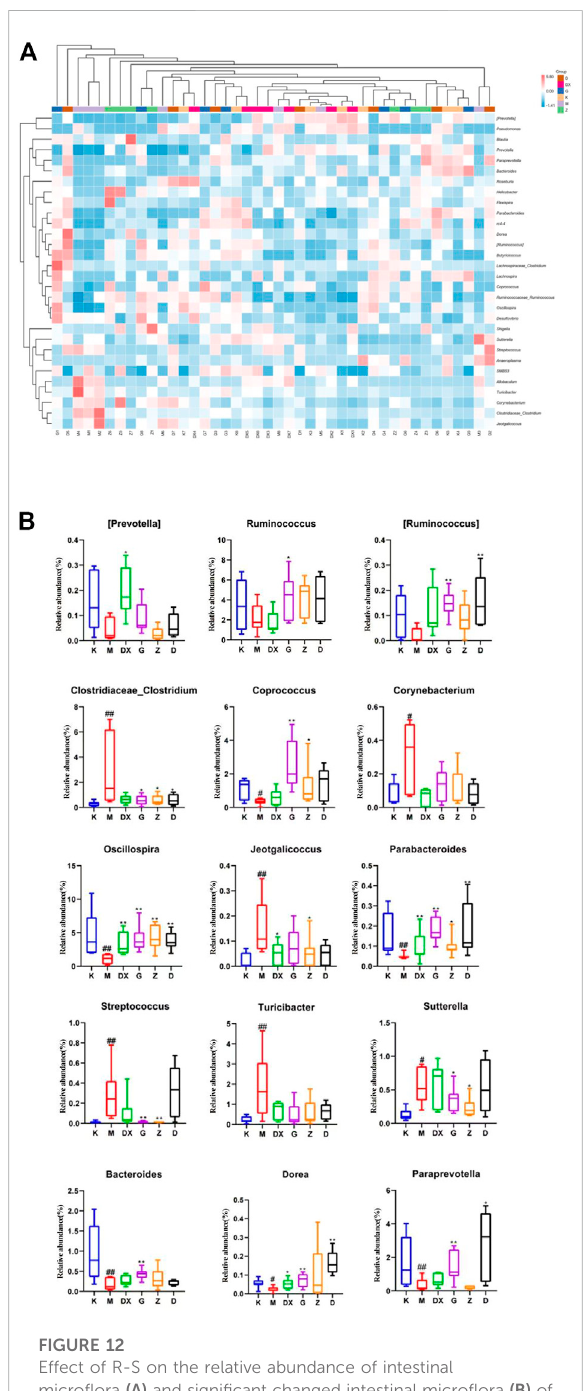
FIGURE 11 Effect of R-S on the relative abundance of intestinal micro fl ora (A) and signi fi cant changed intestinal micro fl ora (B) of insomniac rats ( n = 7) in family.